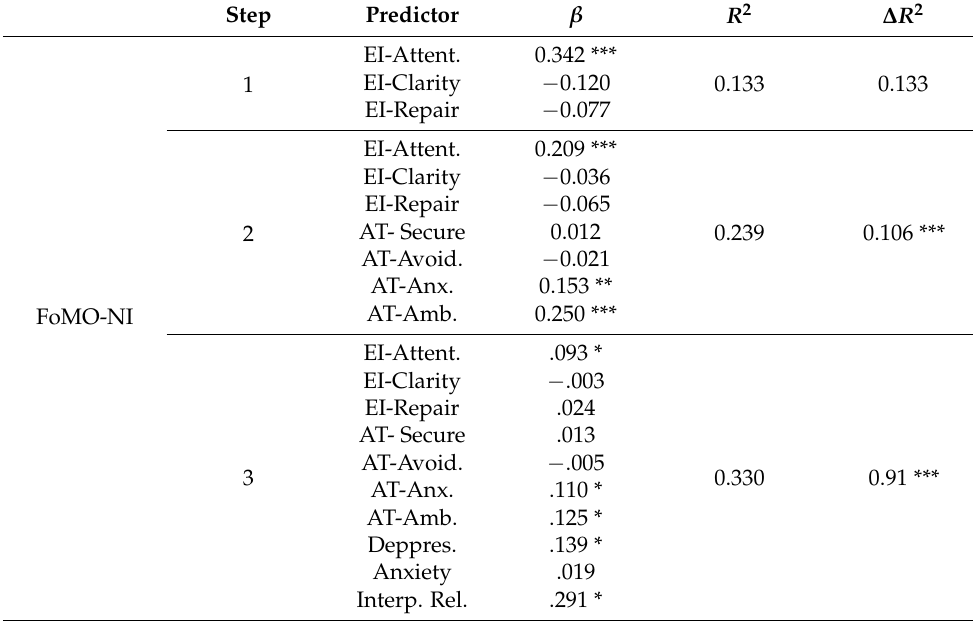
Table 4. Regression model results for the FoMO